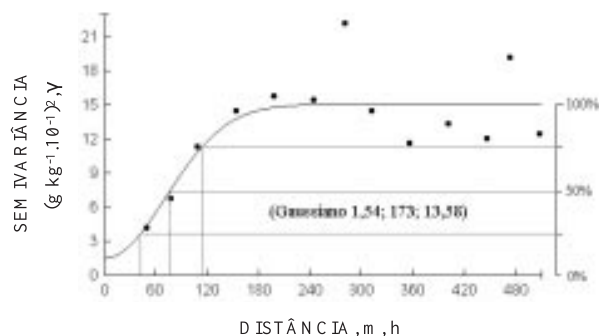
Figura 1. Semivariograma isotrópico para o teor de argila superficial do solo (0-20 cm). (Entre parênteses; modelo; efeito pepita; alcance e patamar).